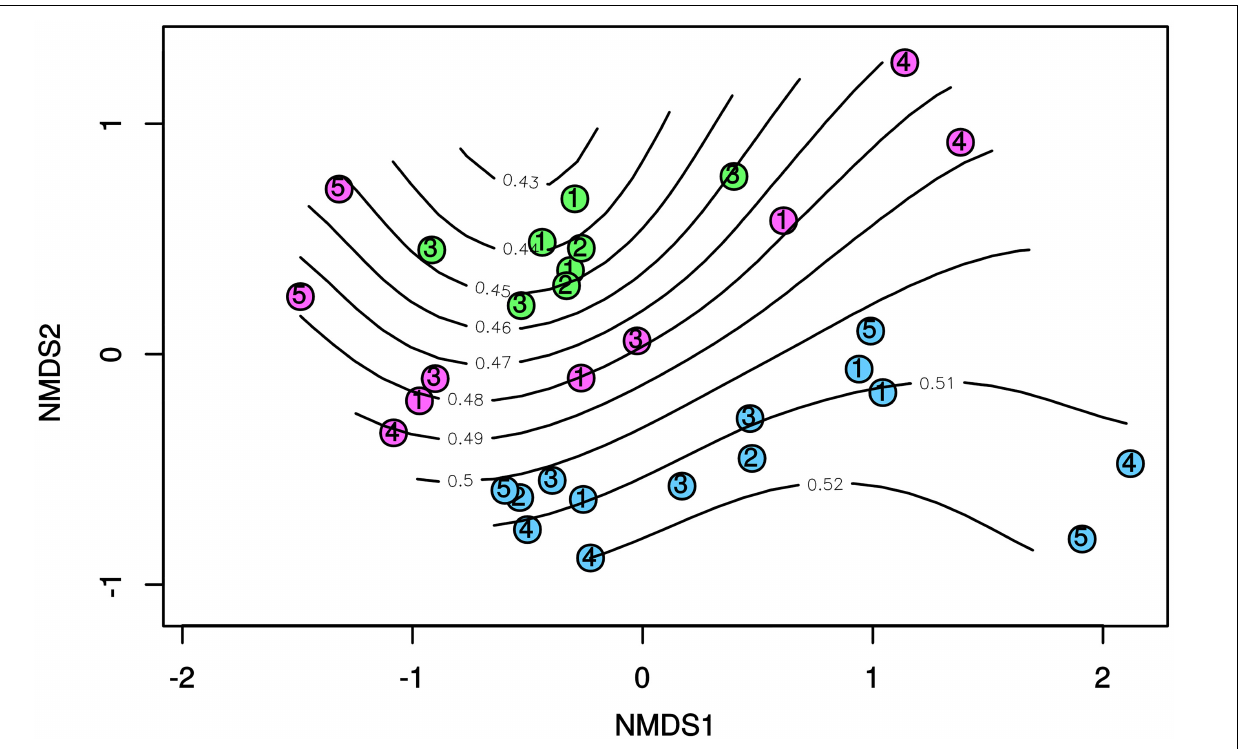
FIGURE 5 | nMDS based on Bray-Curtis dissimilarity in the T-RFLP profiles of dsrAB genes. Isolines indicate values Inp/Inp + BgP ratio in surface sediments as fitted by ordisurf . Blue: Cagliari; Green: El Kantaoui; Pink: Heraklion.